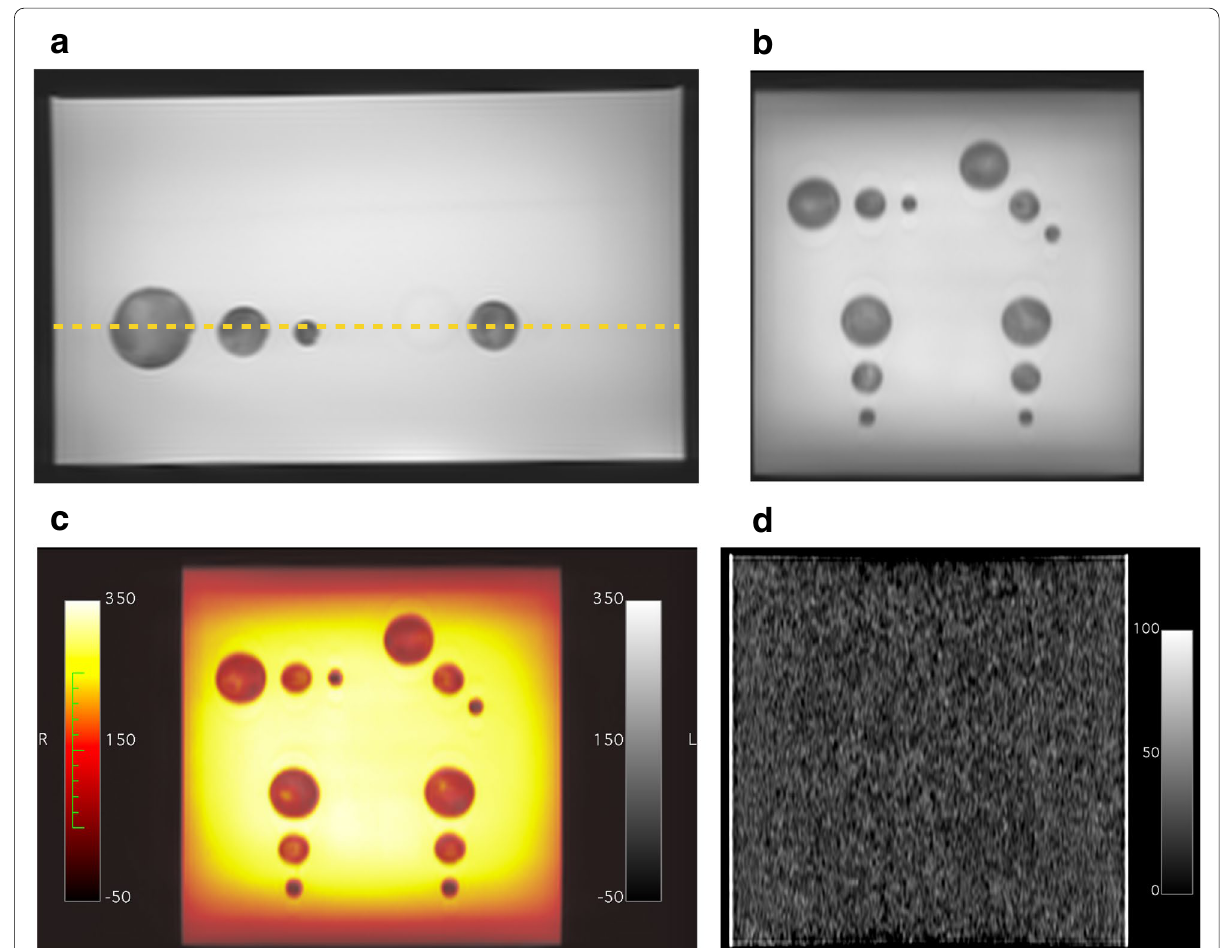
Fig. 6 Biopsy phantom. a Axial/side view T2‑weighted magnetic resonance image, with dashed yellow line showing location of coronal reformats. b Coronal/birds’ eye view reformat of T2‑weighted images. c Fused magnetic resonance images of two separate biopsy phantoms showing the same position of targets. d Computed tomography appearances using a narrow soft tissue (brain) window to confirm targets are